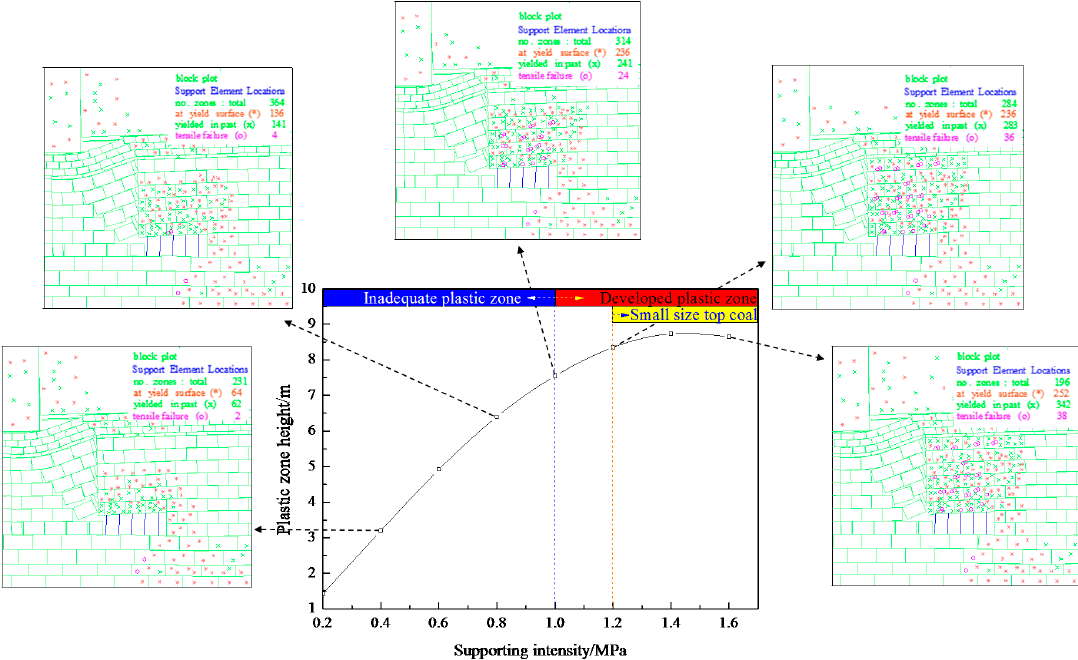
Figure 5. Top coal plastic zone under different supporting strengths.